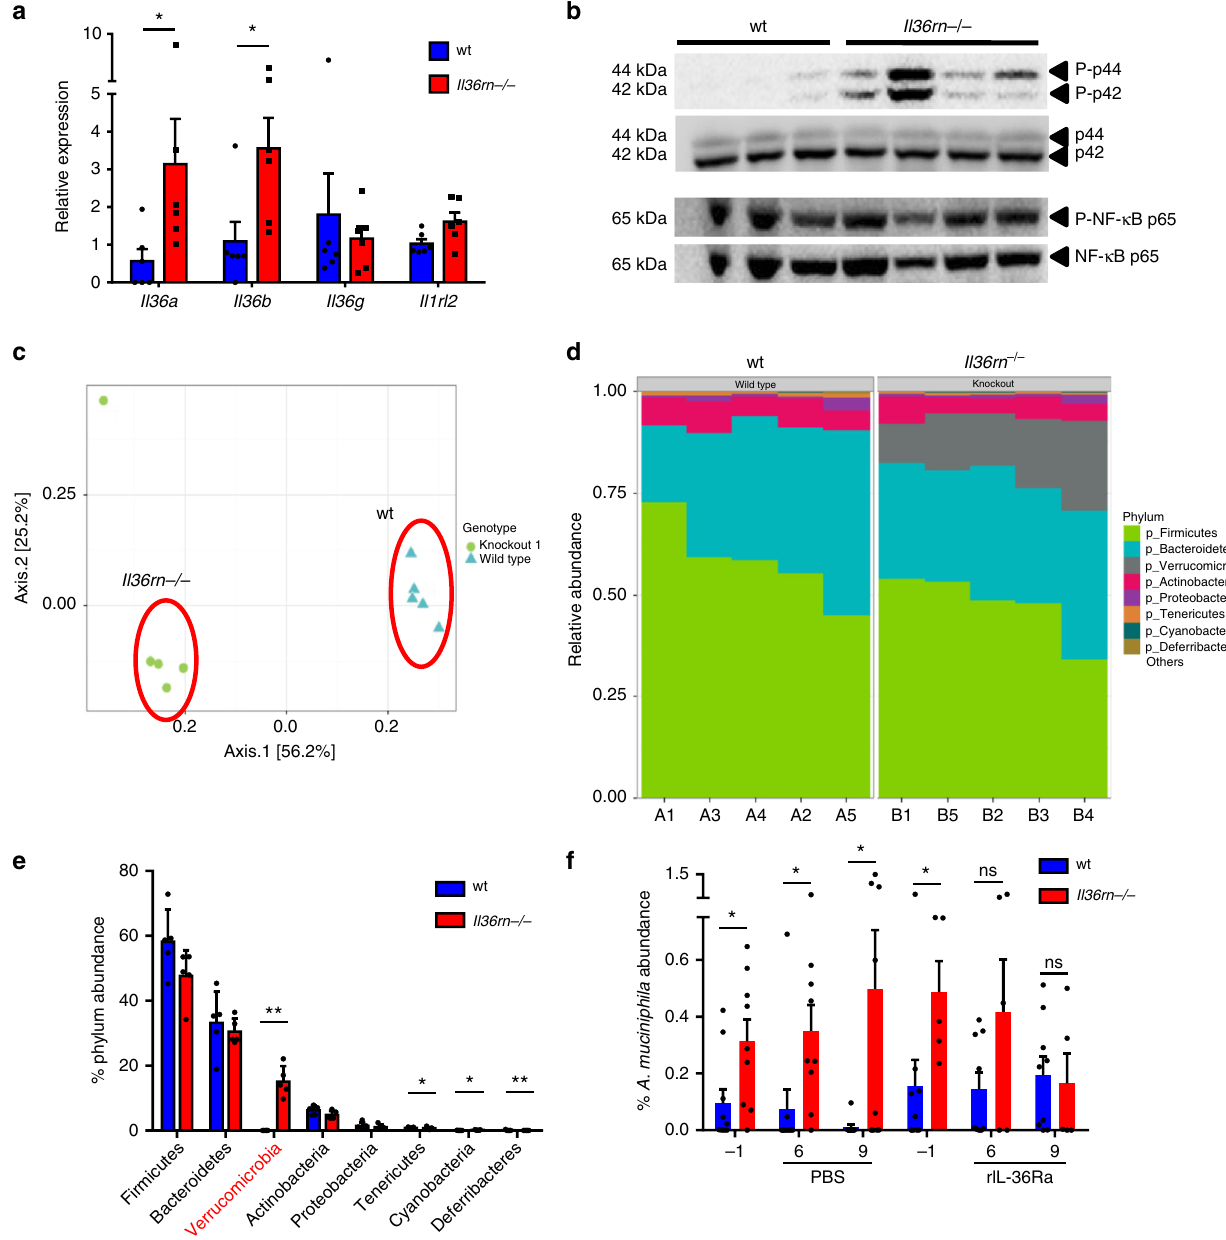
Fig. 4 Altered composition of intestinal microbiome in Il36rn − / − mice dependent on IL-36 activity. a Relative gene expression of IL-36 cytokines and IL-36 receptor in the colon of wt and Il36rn − / − mice ( n = 6 per group). b Protein expression of phospho-p44/p42 (Thr202/Tyr204, P-p44/P-p42) with total p44/p42, and phospho-NF- κ B p65 (Ser536, P-NF- κ B p65) with total NF- κ B p65, in the colons of wt ( n = 3) and Il36rn − / − ( n = 4) mice. c Weighted ordination by principal coordinate analysis (PCoA) of beta-diversity of intestinal microbiome composition in wt and Il36rn − / − mice ( n = 5 per group). d Proportional relative abundance of the most abundant phyla in the microbiome of wt and Il36rn − / − mice. e Percent relative abundance means ± SD of the eight most abundant phyla, Kruskal – Wallis rank sum test to determine signi fi cance. f Percent relative abundance of Akkermansia muciniphila in regard to total bacteria in the microbiome of 8 – 10-week-old wt and Il36rn − / − mice, as determined by qPCR using speci fi c primers, before (day − 1) and after (days 6, 9) three i.p. injections of rIL-36Ra ( n = 9 and 5) or PBS control ( n = 9) (days 1, 2, 3) were performed . Data show means ± SEM unless otherwise described. Statistical analysis using two-tailed Mann – Whitney test for ( a ) and ( f ), or as described. ns p > 0.05, * p < 0.05, ** p < 0.01. Source data